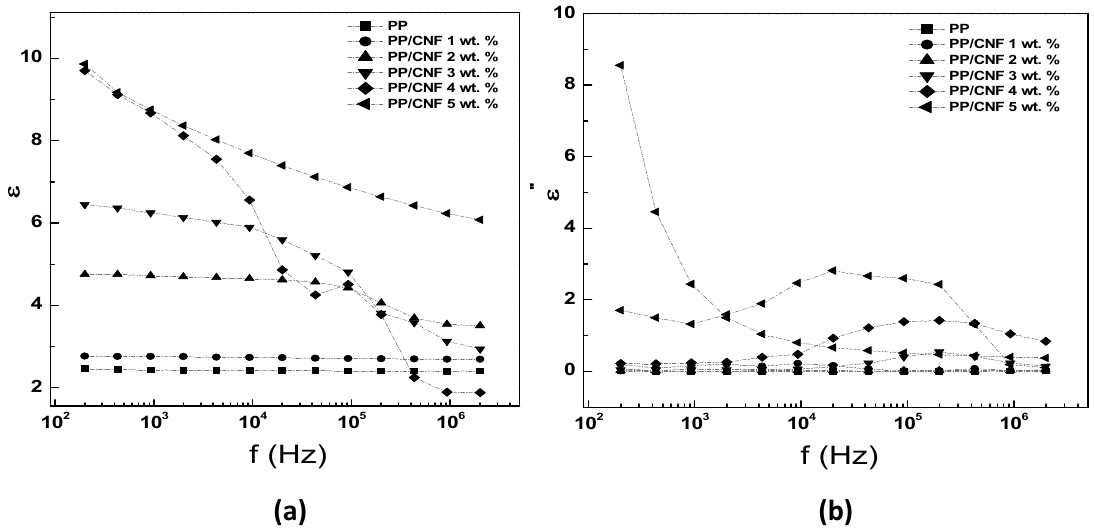
Figure 4. Dependence on frequency of dielectric permittivity in PP/CNF composites. Real ε (cid:48) ( ω ) ( a ), and imaginary ε (cid:48)(cid:48) ( ω ) ( b ) parts of complex dielectric permittivity (the dash-dot lines are to guide the eyes). Reprinted with permission from Ref. [20]. Copyright 2017, Elsevier.